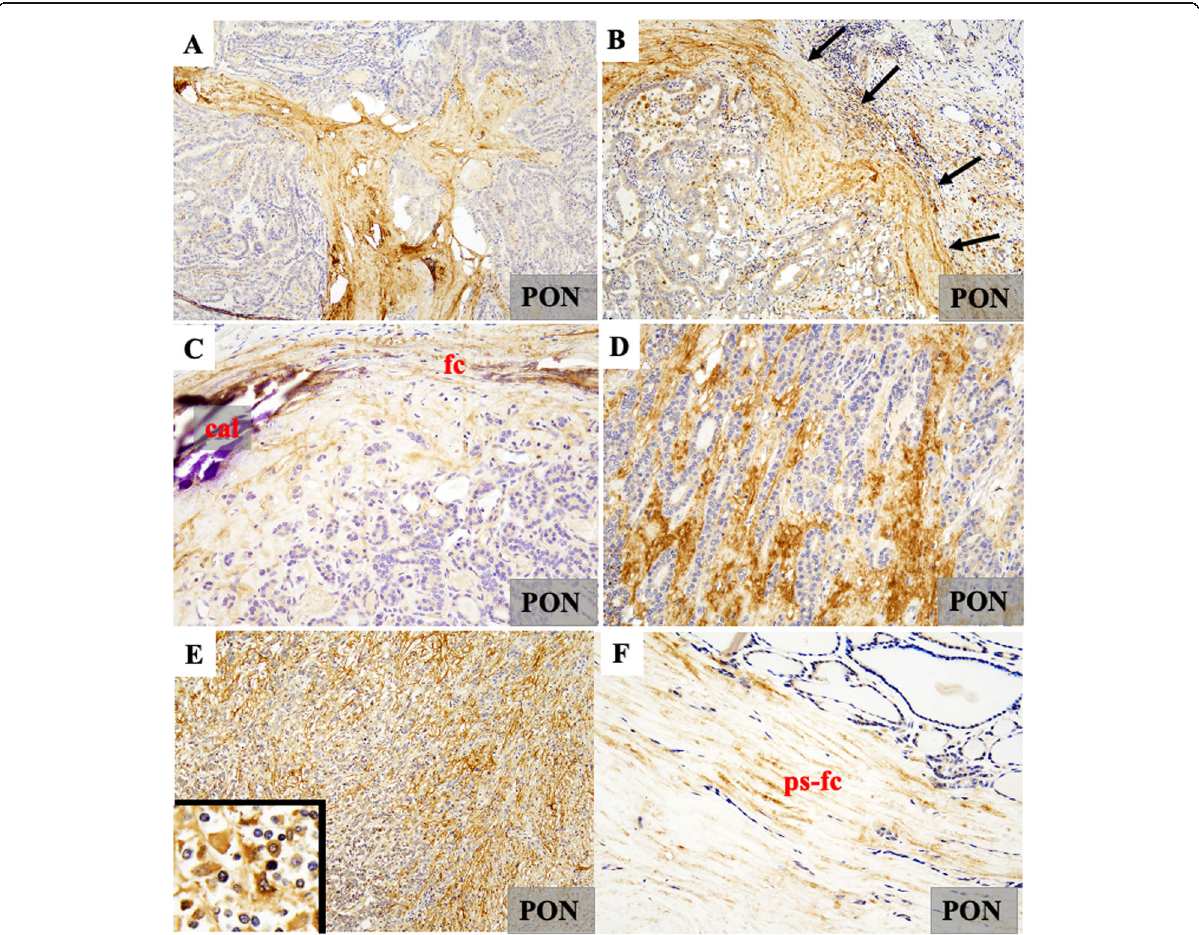
Fig. 2 Results of immunohistochemical staining for periostin (PON) in each thyroid nodule. A Microcarcinoma. Immunopositivity for PON was observed in the sclerotic stroma. B Papillary carcinoma. Moderate to strong immunopositivity for PON was observed in the sclerotic stroma around the neoplastic follicles. C Follicular adenoma. Weak immunopositivity for PON was noted in the fibrous capsule (fc), together with some calcification (cal). D Widely invasive follicular carcinoma. Diffuse immunopositivity for PON was detected in the sclerotic stroma in the invasive regions. E Undifferentiated carcinoma. Strong immunopositivity for PON was diffusely observed in the stroma around cancer cells. (E, inset) PON immunoreactivity was also observed in the cytoplasm of cancer cells. F Adenomatous goiter. Very weak signals for PON were found in